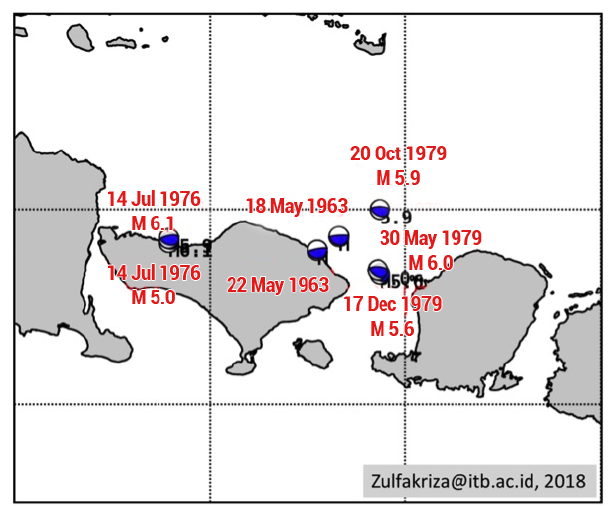
Fig. 3. Earthquakes that have occurred in Lombok in